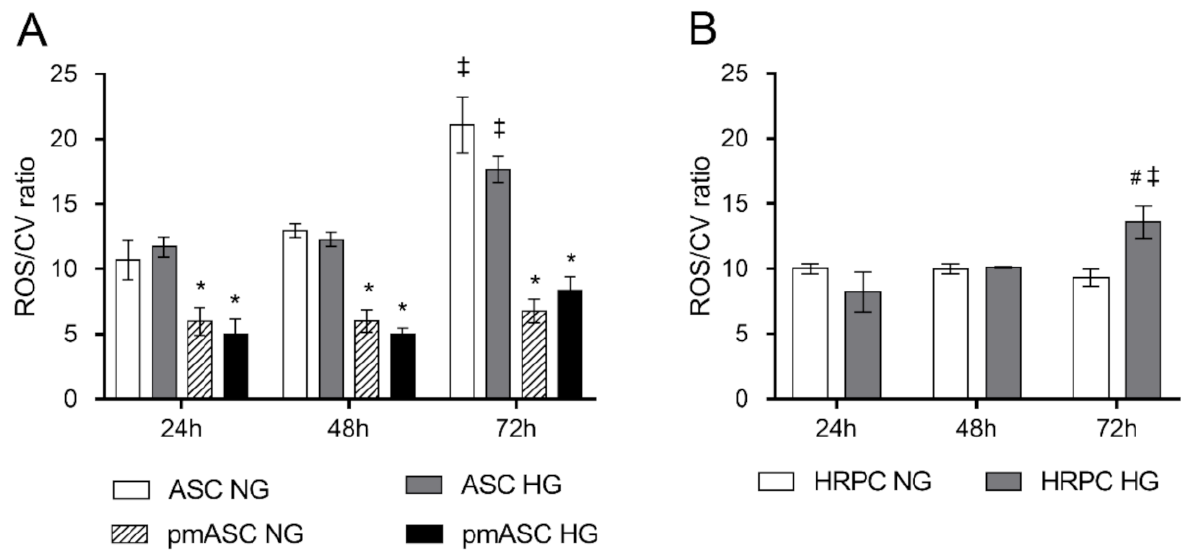
Figure 4. High glucose effects on ROS levels evaluated by H2DCFDA assays in ( A ) human adipose mesenchymal stem cells cultured in basal medium (ASC) or in pericyte medium (pmASC), and in ( B ) human retinal pericytes (HRPC). In some samples, glucose was added to the culture medium (High Glucose, 25 mM, HG); data were gathered after 24 h, 48 h and 72 h from glucose addition, and compared to samples kept in normal glucose (NG) condition. ROS values of each group are normalized by the corresponding population density, as determined by crystal violet staining, at each corresponding time point (ROS/CV ratio). Values are expressed as mean ± SEM of three independent experiments. * p < 0.05 pmASC vs. ASC; # p < 0.05 HG vs. NG; ‡ p < 0.05 72 h vs. 24 h; Two-way ANOVA, followed by Sidak’s